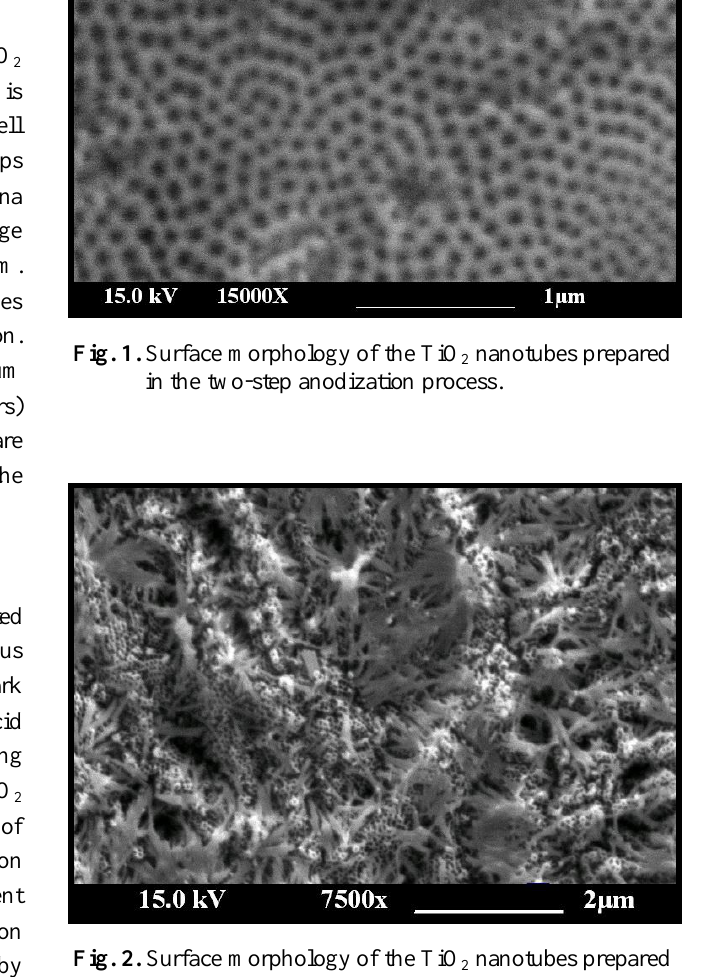
nanotubes prepared 2